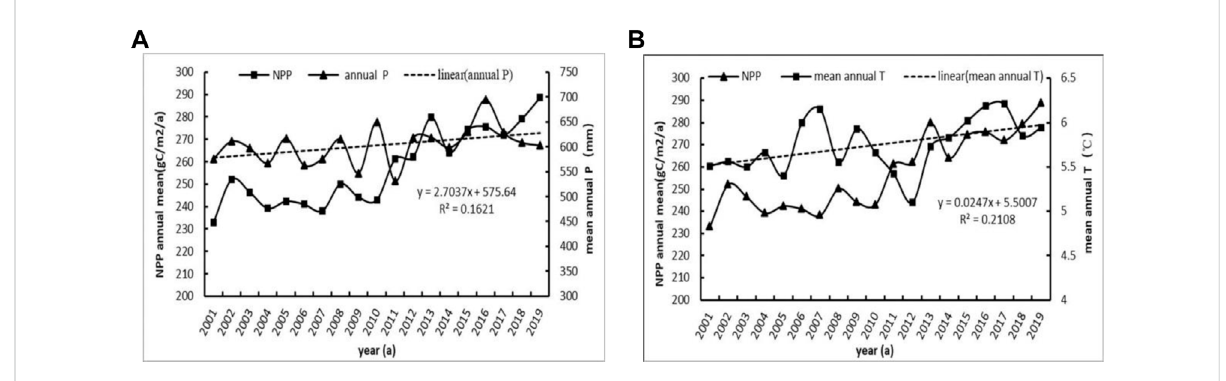
FIGURE 7 The relationship between NPP and annual precipitation (A) , annual mean temperature (B) of grassland in China from 2001 to